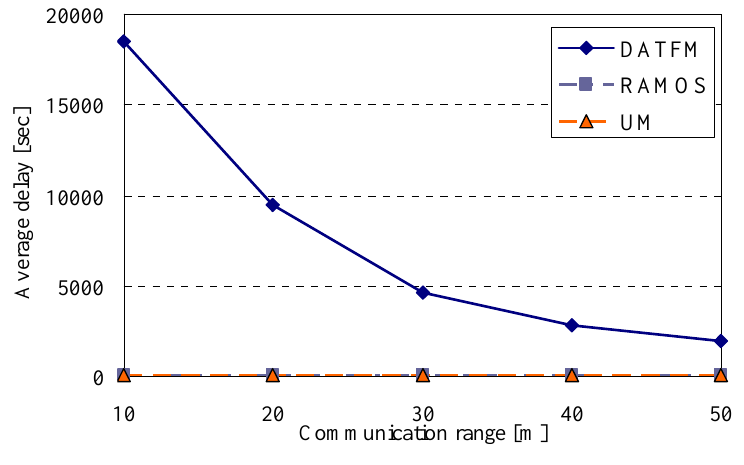
Figure 18. Communication range and average